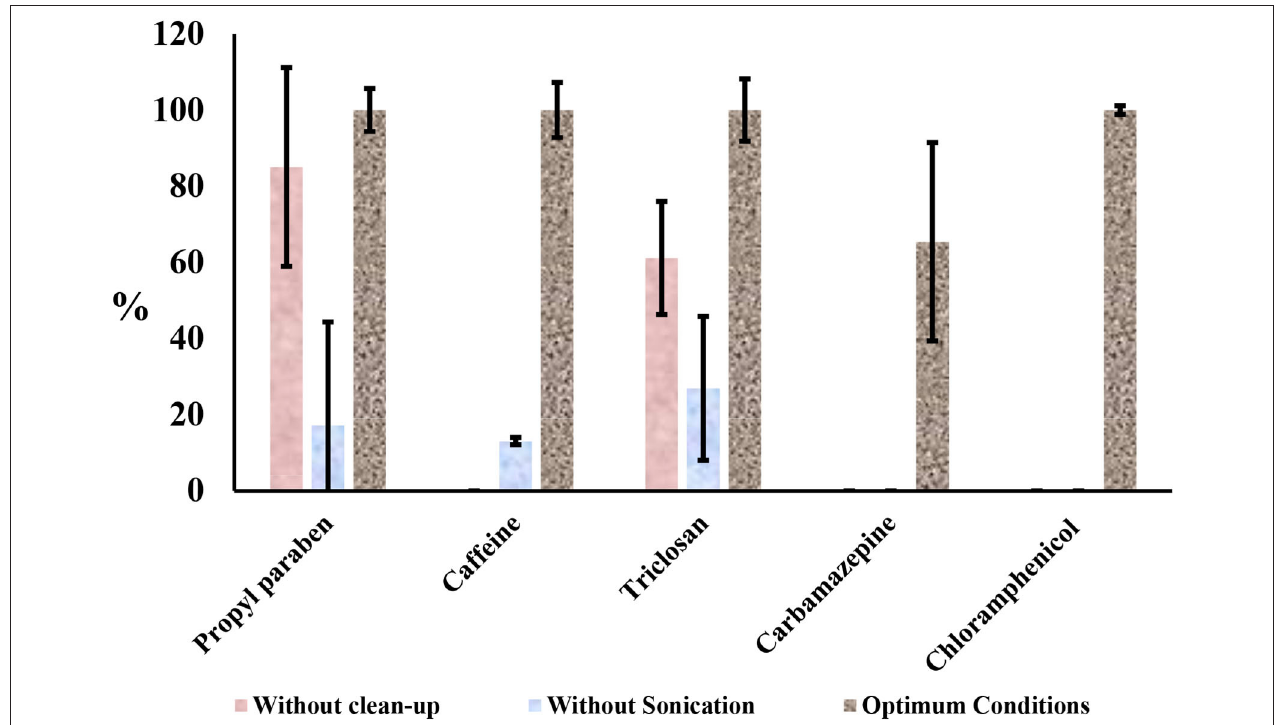
FIGURE 2 | Influence of sonication and cleanup steps in the simultaneous extraction of target compounds from spiked sediments samples at 10 ng g − 1 .